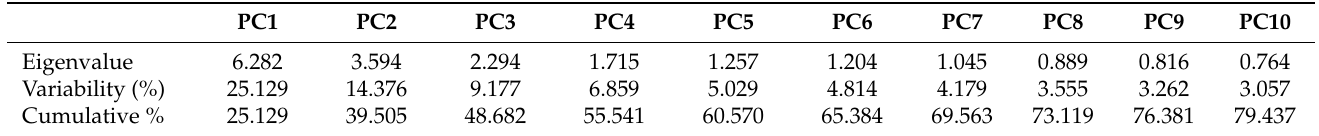
Figure 2. Scree plot showing eigenvalues in response to number of components for the estimated variables of winter wheat varieties at both locations. Table 1. Principal component analysis of 24 different wheat metabolites and resistance to Fusarium at both